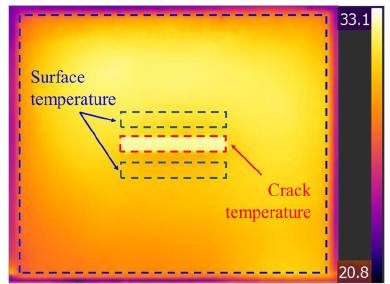
Figure 4. Example of thermal images.